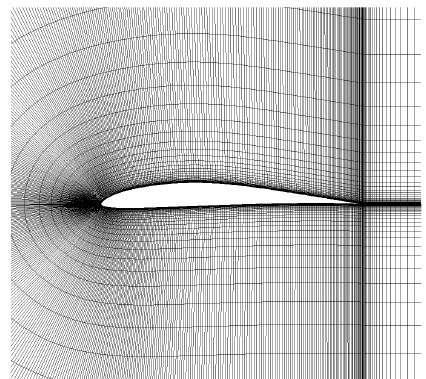
Figure 13. Mesh for calculating of E387 airfoil.